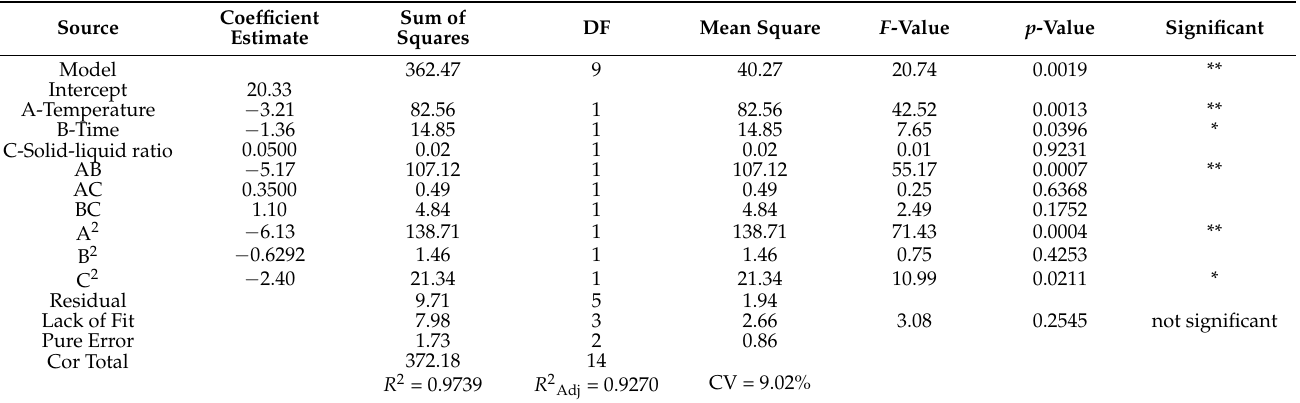
Table 2. Regression coefficients and their significances for XOS production from the results of the Box-Behnken experimental